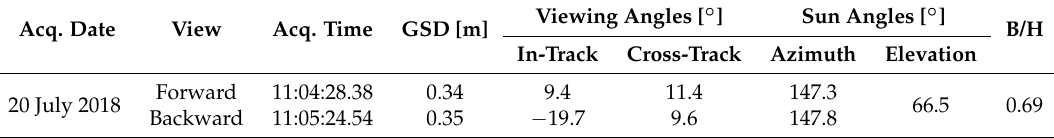
Table 1. Acquisition properties for the stereo satellite image dataset over